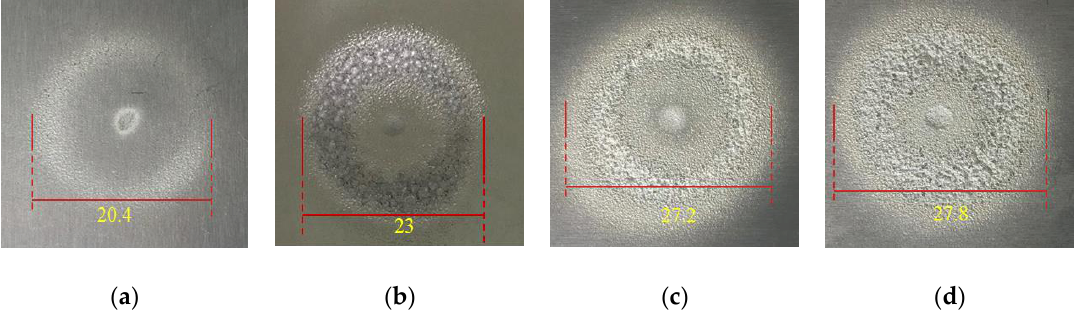
Figure 9. Surface morphology change of the samples at different impact times (unit in mm): ( a ) t = 10 min; ( b ) t = 30 min; ( c ) t = 60 min; (d) t = 90 min.